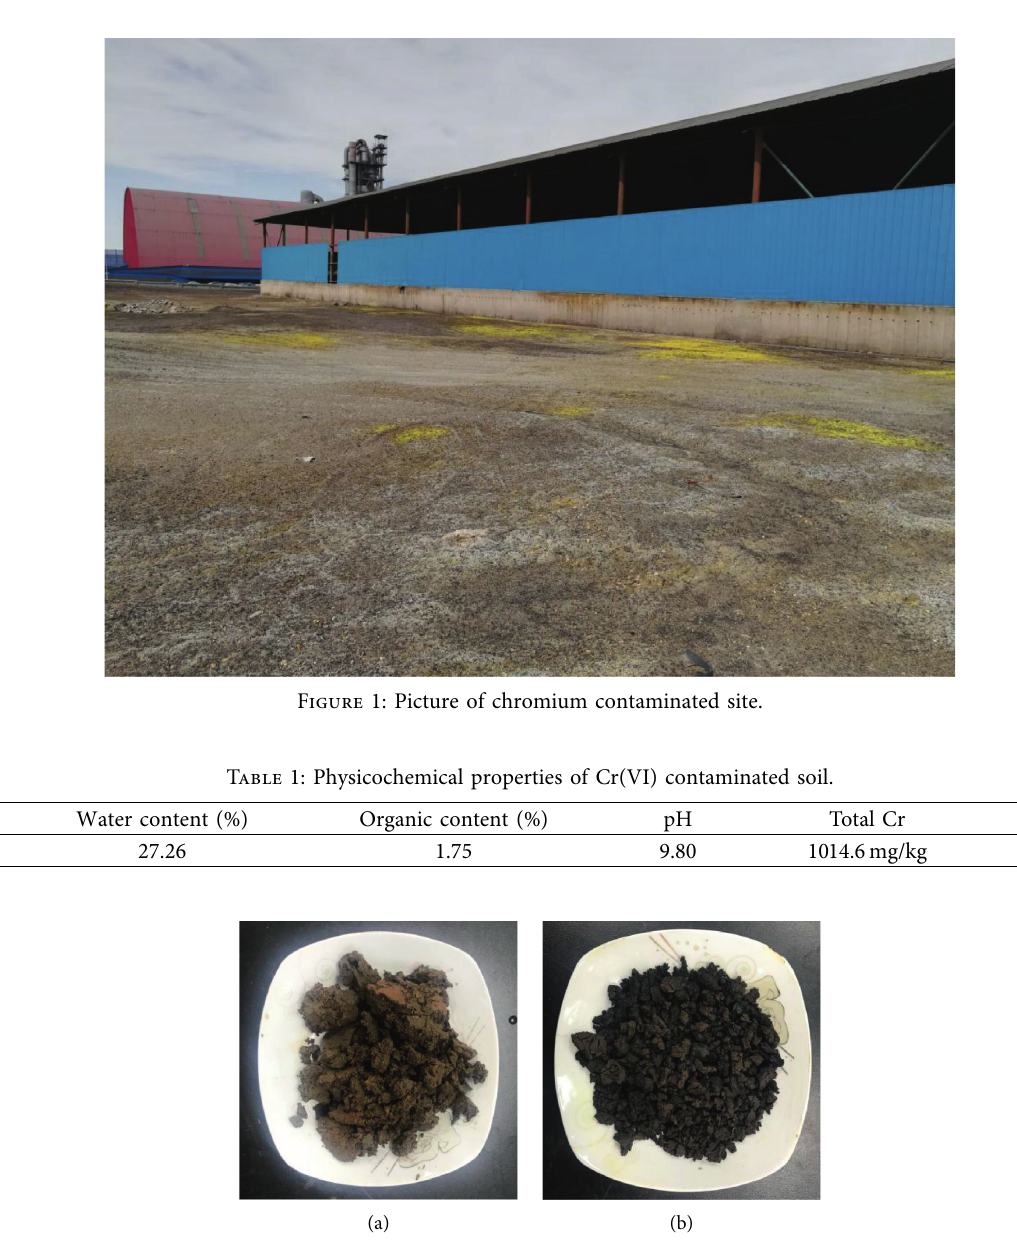
Figure 2: Picture of sewage sludge and CHBC. (a) Sewage sludge. (b) CHBC.